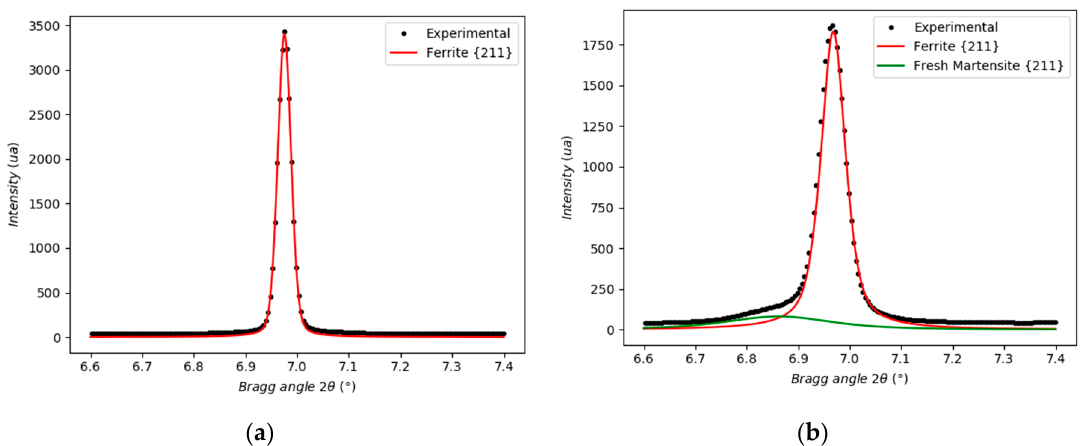
Figure 2. Comparison between the experimental diffractogram (in black) and the modelled profiles for the two BCC phases (ferrite in red and strain-induced martensite in green) ( a ) before the tensile trial and ( b ) just before necking.